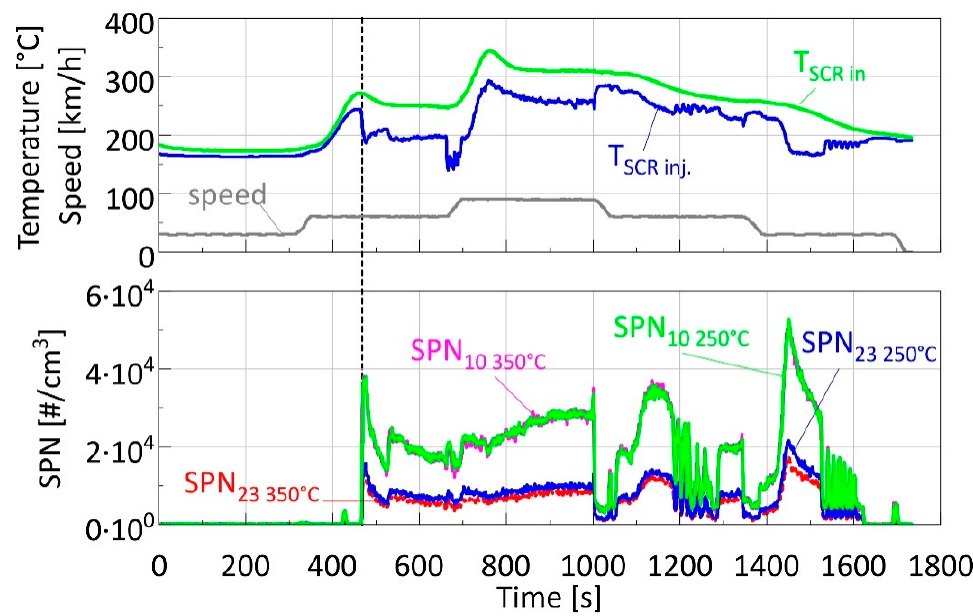
Figure 8. Solid Particle Number (SPN) concentrations (bottom panel) at the outlet of the SCR during the speed ramp tests, as measured with CS 2 at its default VPR operating temperature of 350 °C and CS 1 set at a VPR temperature of 250 °C. The corresponding velocity profile as well as the temperatures measured at the inlet of the SCR and in front of the urea injector are shown on the top panel. The dashed vertical line only serves as a guideline depicting the start of urea injection based on the temperature measurements. CS = Catalytic Stripper; SCR = Selective Catalytic Reduction; VPR = Volatile Particle Remover.